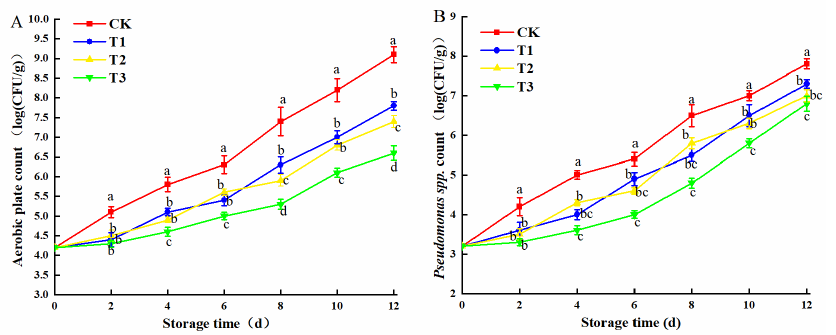
Figure 9. Changes in aerobic plate count ( A ) and Pseudomonas spp. count ( B ). The means with differ- ent lowercase letters (a–d) in figure differ significantly ( p < 0.05). different lowercase letters (a–d) in figure differ significantly ( p <